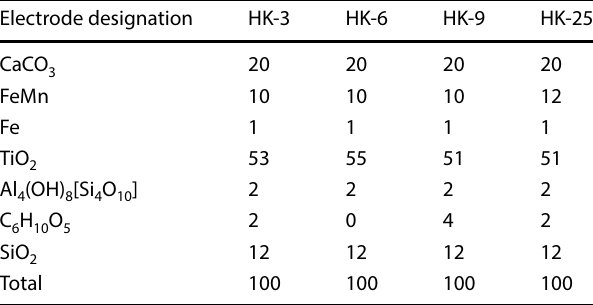
Table 1 Composition of the electrodes’ coatings (in wt.-%)